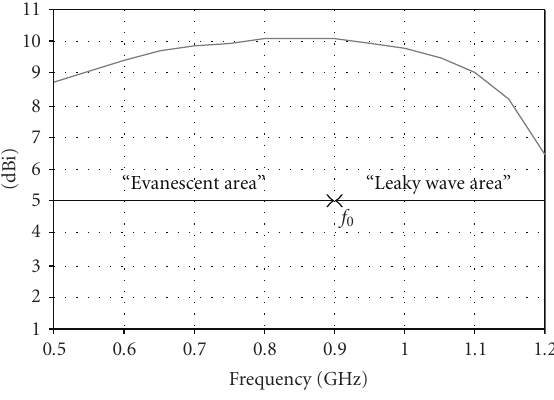
Figure 14: Directivity versus frequency.